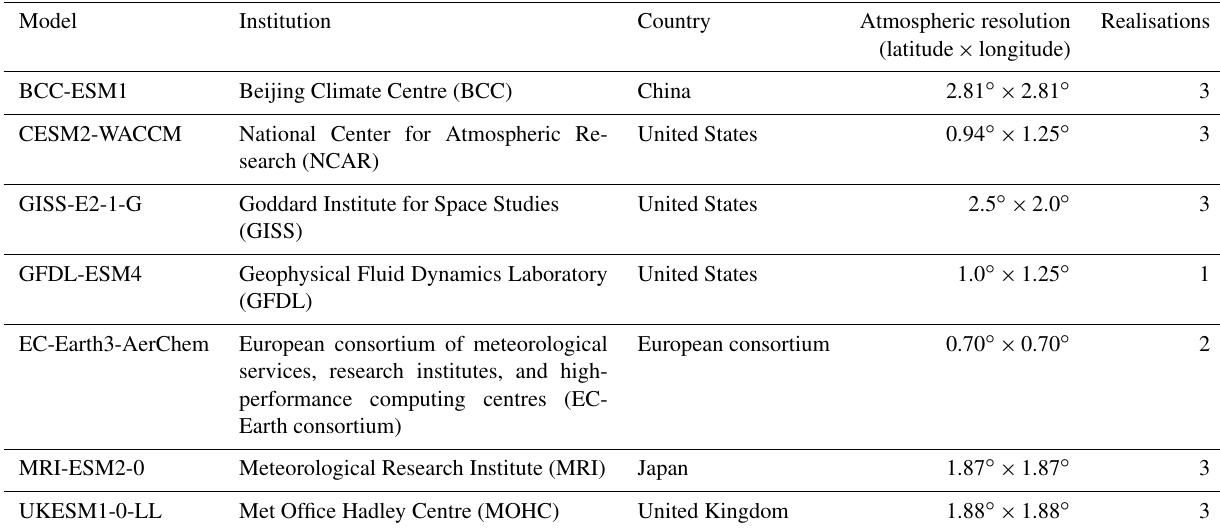
Table 1. Summary of CMIP6 models used in this study.